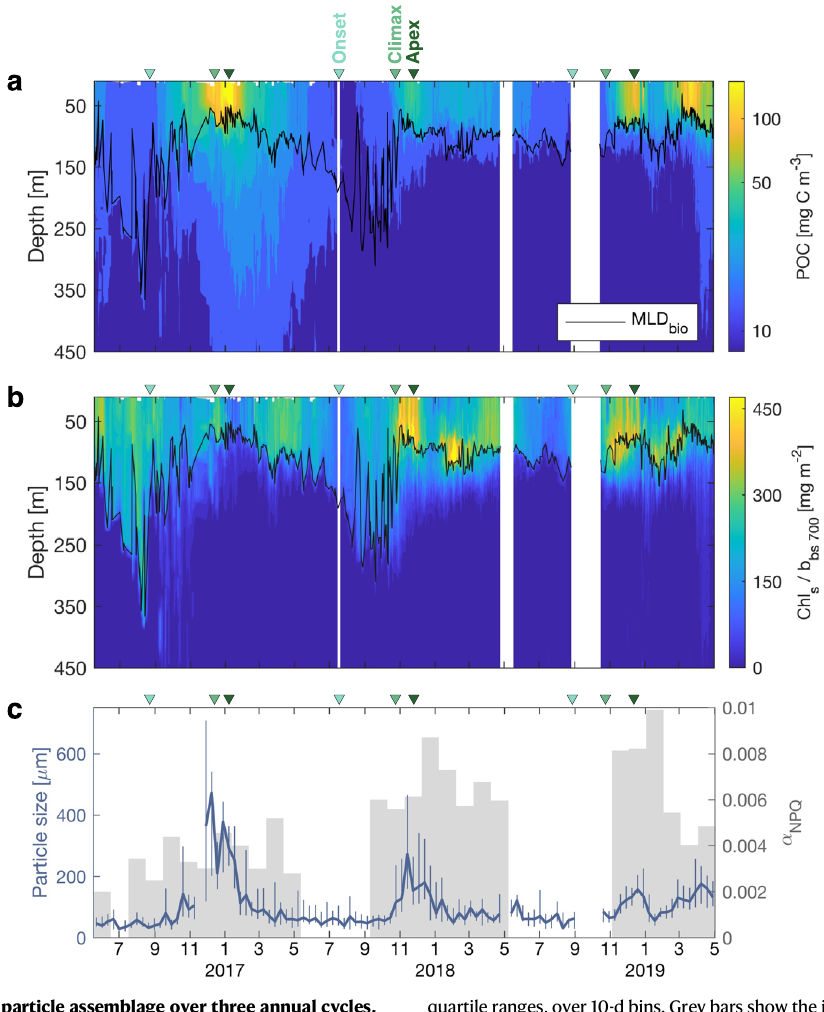
quartile ranges, over 10-d bins. Grey bars show the iron stressindex α NPQ averaged over 30-d bins. α NPQ was derived from the non-photochemical signal in fl oat fl uorescence pro fi les (see Methods). As milestones, triangles on top of each panel mark the timing of onset ( fi rst positive net phytoplankton accumulation), climax (maximum accumulation) and apex (maximum phytoplankton carbon stock) for each bloom, following the method in Uchida et al. 2019 68 (see